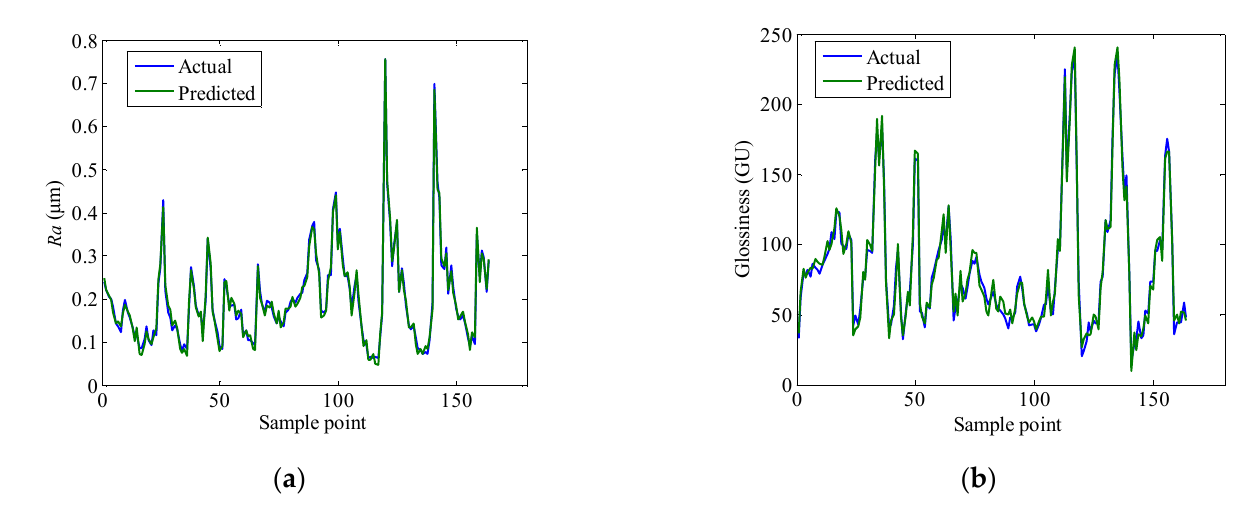
Figure 8. Prediction performance of surface quality evolution models: ( a ) surface roughness, ( b ) glossiness.